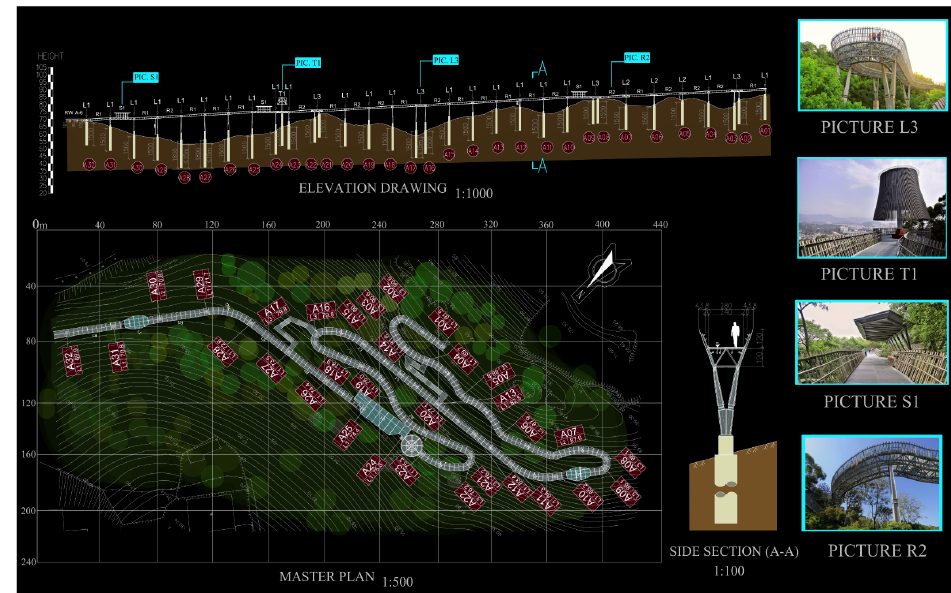
Figure A3. The combination of different modules for one section of the Fu Forest Trail (Source: author’s work).